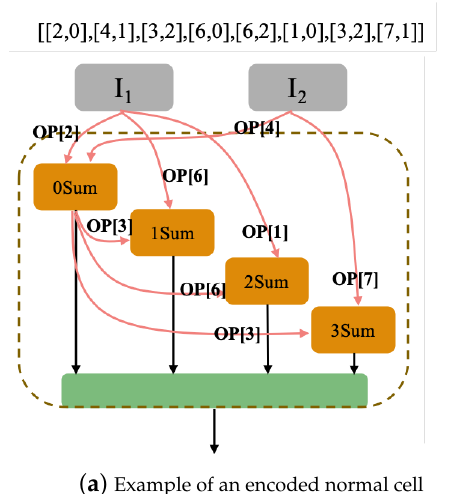
Figure 4. An example of an encoded architecture, including an encoded normal cell and a reduction cell with four intermediate nodes. There are eight elements in each cell with four intermediate nodes. ( a ) An example of an encoded normal cell. The 0th intermediate node, as well the 2th node in the cell, are calculated by the sum of two elements OP [2] computed based on the 0th node in the cell and OP [4] computed based on the 1th node in the cell, where the 0th and 1th nodes in the cell are the two input nodes. All the remaining intermediate nodes are encoded into arrays in the same way. ( b ) An example of an encoded reduction